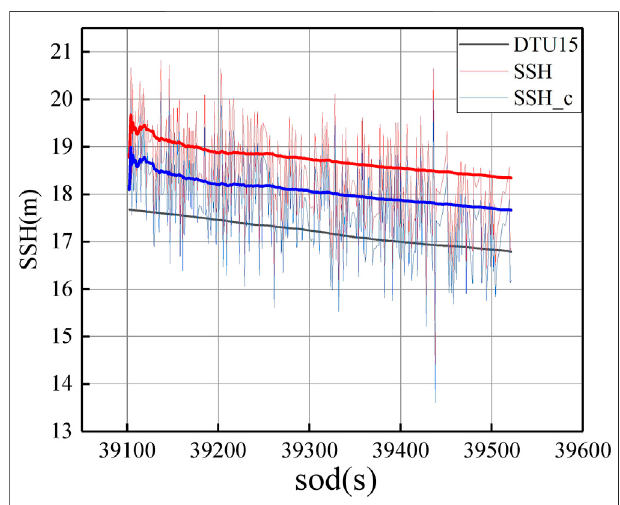
FIGURE 6 | Sea surface height inversion results of